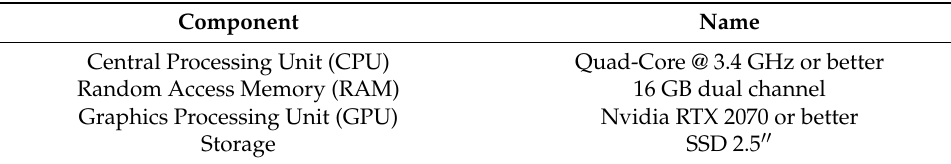
Figure 1. Different magic mirror setups side-by-side. Table 1. Desktop